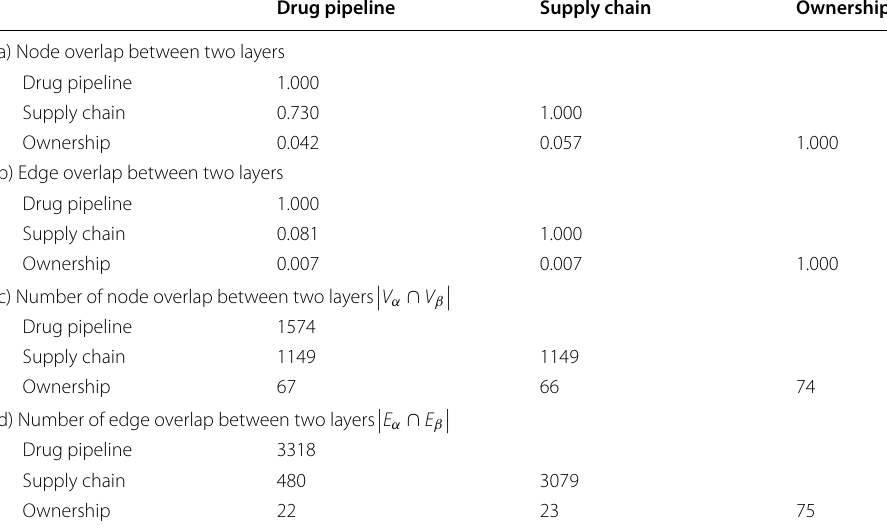
We ignore the multiple edges in the drug pipeline layer